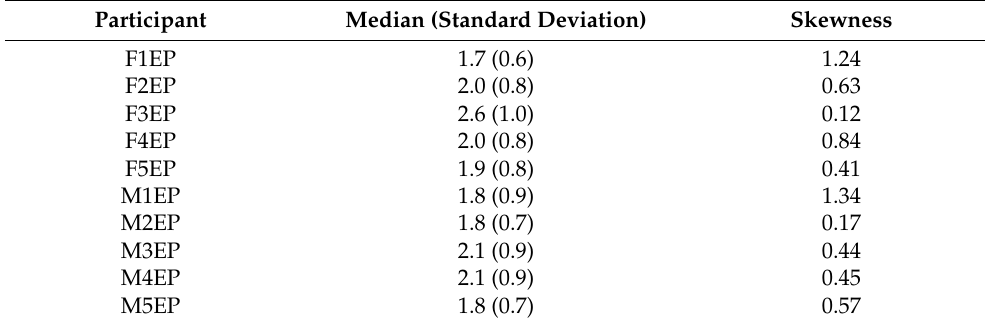
Table 4. Median (and standard deviation) in s, and Pearson skewness of IPI for the Portuguese participants of the Current